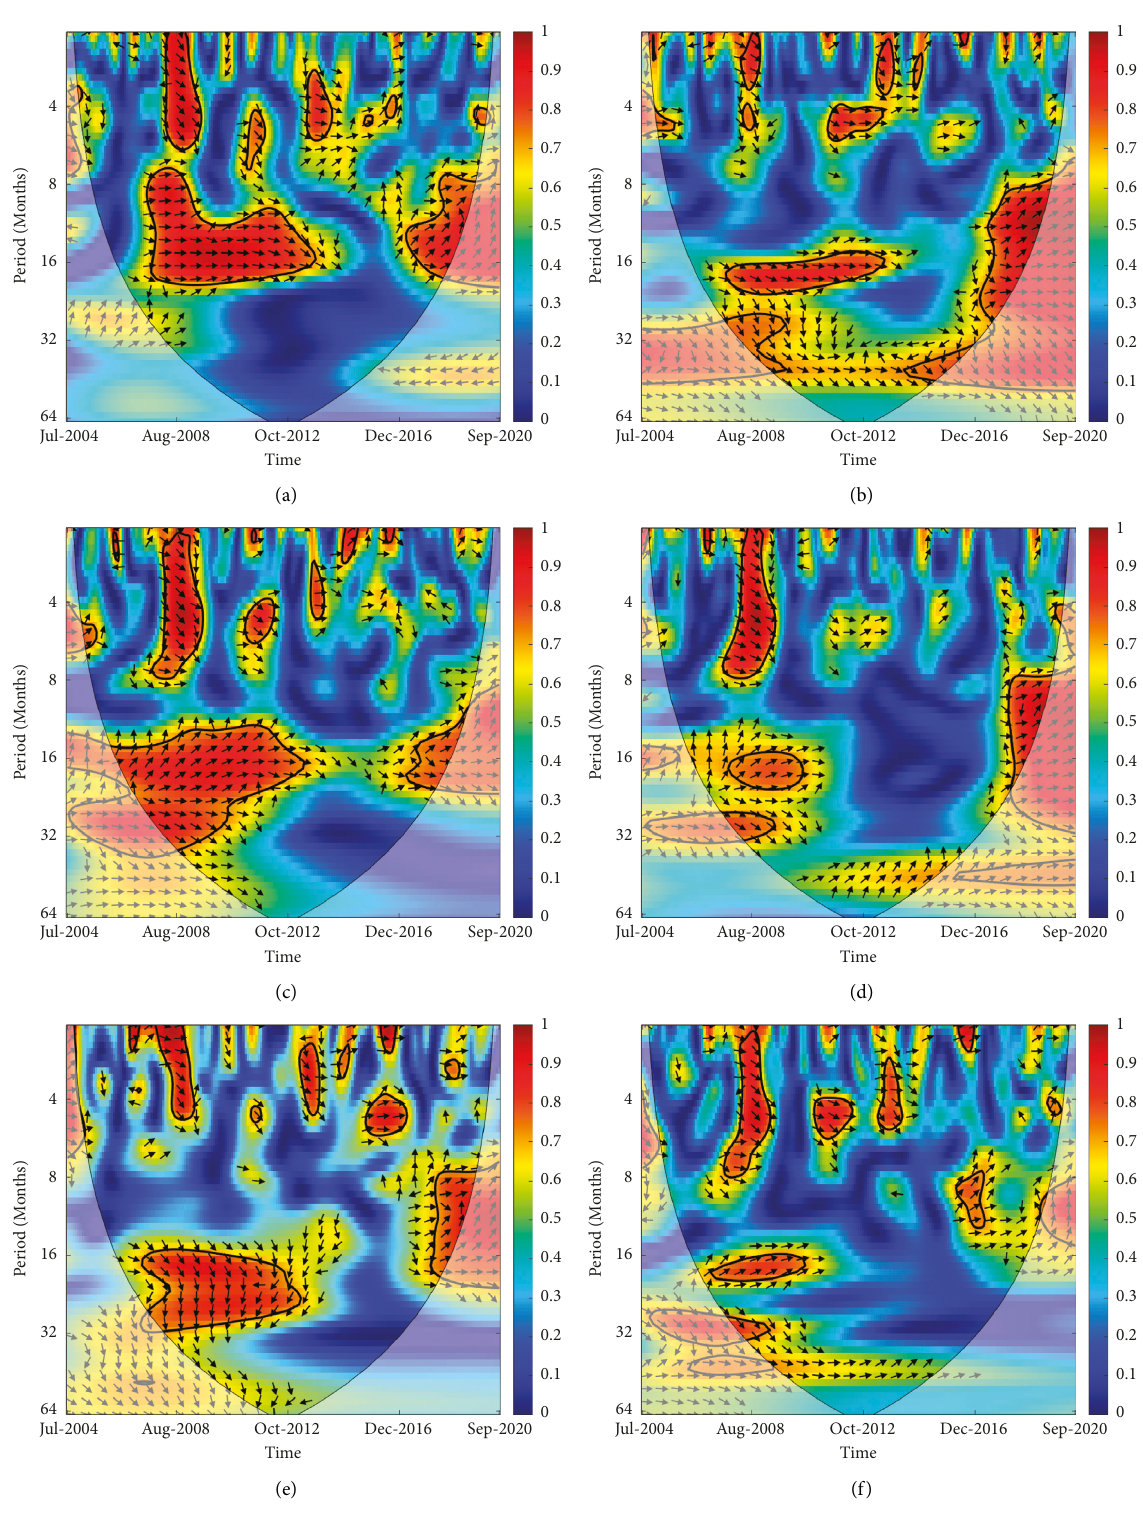
Figure 5: The wavelet coherence and phase plots between the EPU index and MATV for six sectors (communication services, consumer discretionary, consumer staples, energy, financial, and health care). (a) EPU and communication services. (b) EPU and consumer dis- cretionary. (c) EPU and consumer staples. (d) EPU and energy. (e) EPU and financial. (f) EPU and health